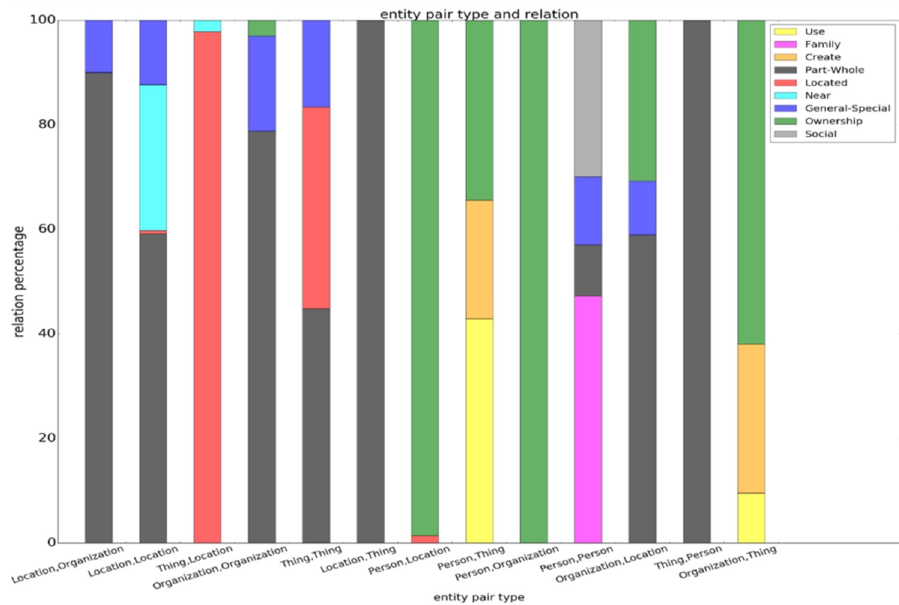
Figure 12. Instance of attention matrix visualization 2.